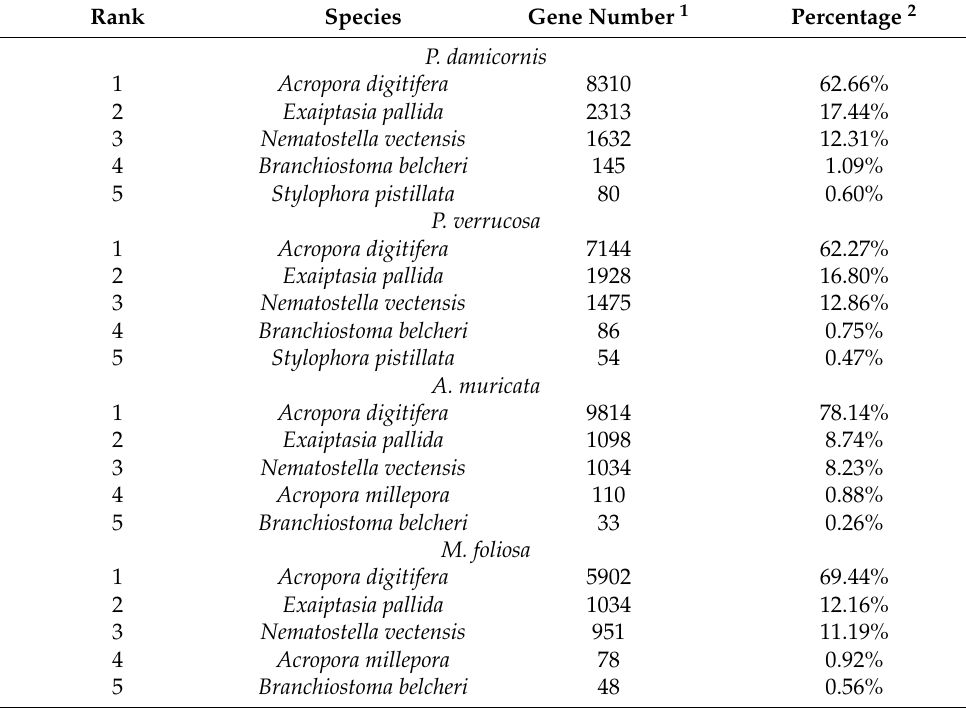
Figure 2. NR database annotations of corals. The top-20 species with the greatest number of top sequence hits for P. damicornis ( a ), P. verrucosa ( b ), A. muricata ( c ), and M. foliosa ( d ) are shown. The horizontal axis represents the species ID, and the vertical axis represents the number of coral unigenes annotated for different species. The pink columns represent species belonging to Anthozoa. The blue columns represent species belonging to the genus Branchiostoma . Table 3. The top-five species with the genes most similar to the four investigated